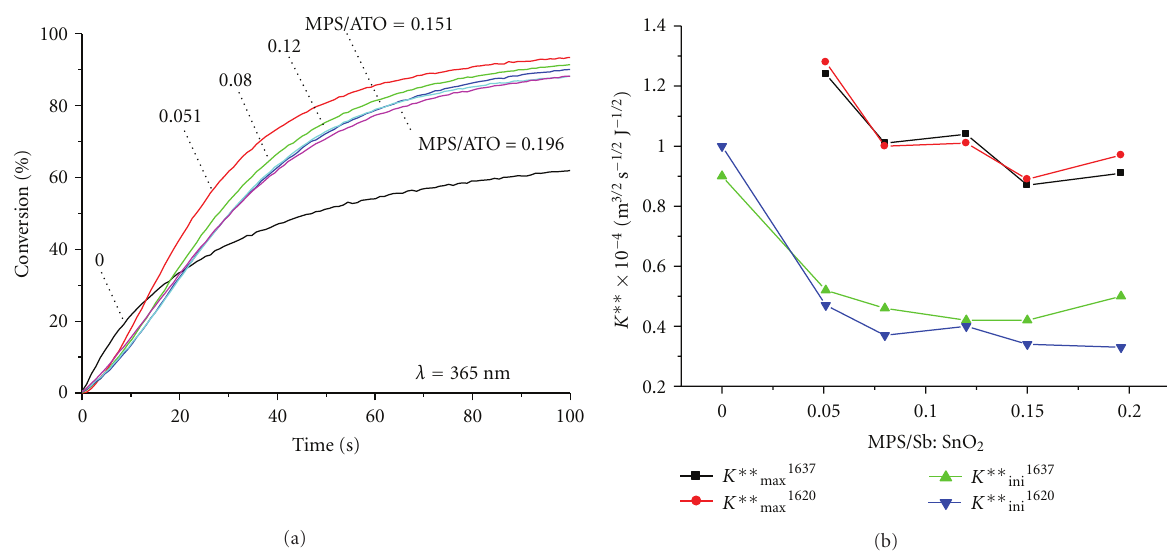
Figure 5: (a) Influence of the amount of MPS present in the starting formulation on the conversion % of the C = C bonds over time; λ = 365nm, Sb = 7%, and c particle = 10vol%. (b) K ∗∗ values calculated from (a).